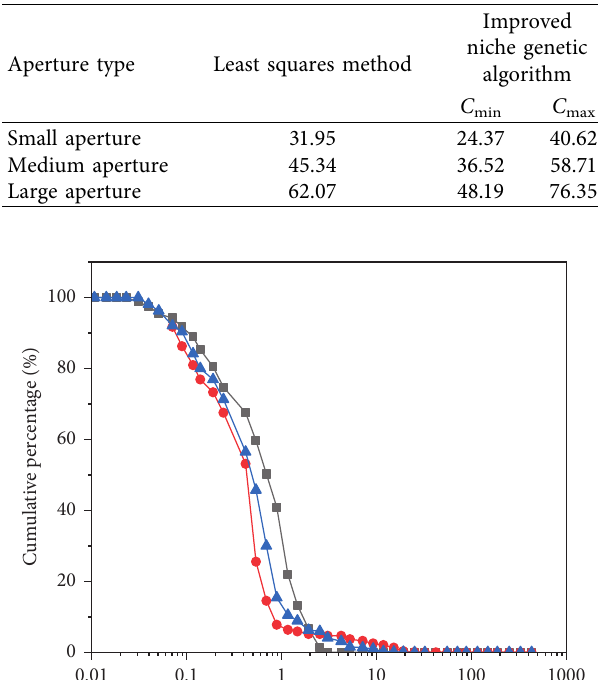
Table 1: Comparison of conversion coefficient inversion results.